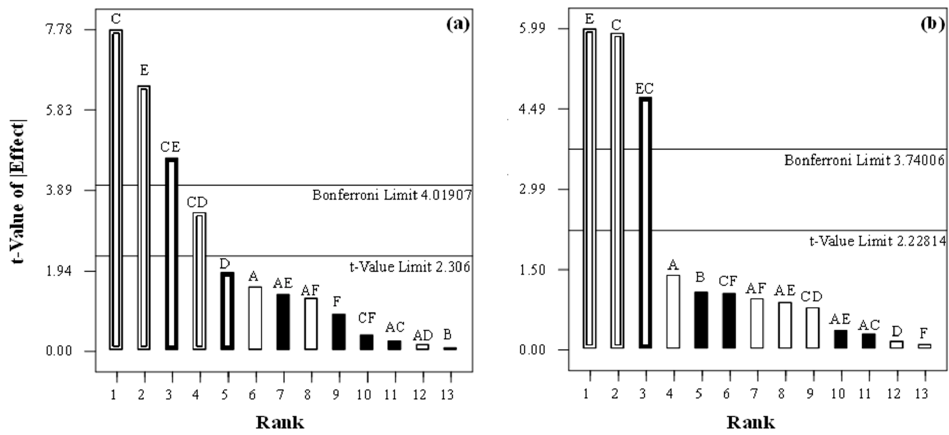
Figure 3. Example of Pareto charts of standardized effect on extraction recoveries of ( a ) E1 and ( b ) E2 for investigated analytes with different magnetic ILs.